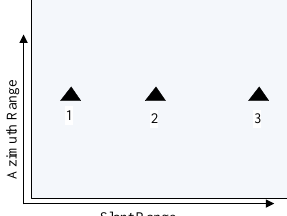
It needs at least 3GCPs to get enough equations to solve the values of the three parameters ( B ,  and